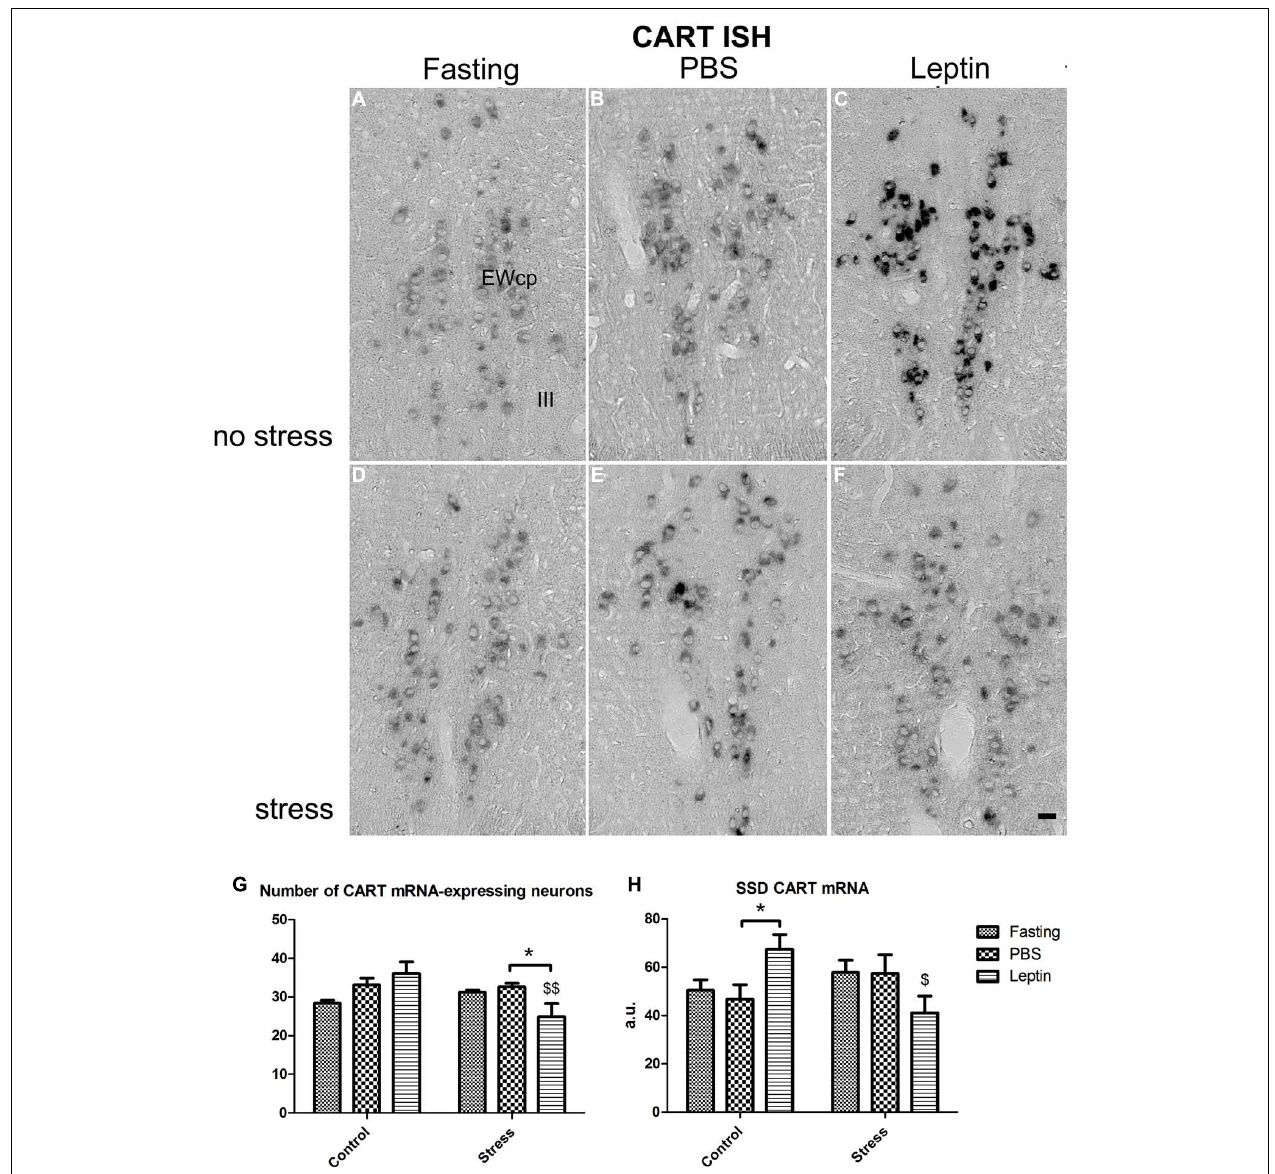
FIGURE 5 | Insitu hybridizationofCARTmRNAinEWcpneurons. (A–C) Fasting,PBS-injectedandleptin-injectedrats, (D–F) thesamethree treatments,respectively,butstressed. (G) NumberofCARTmRNAexpressing neuronsand (H) SSDperperikaryon,expressedinarbitraryunits(a.u.).Vertical